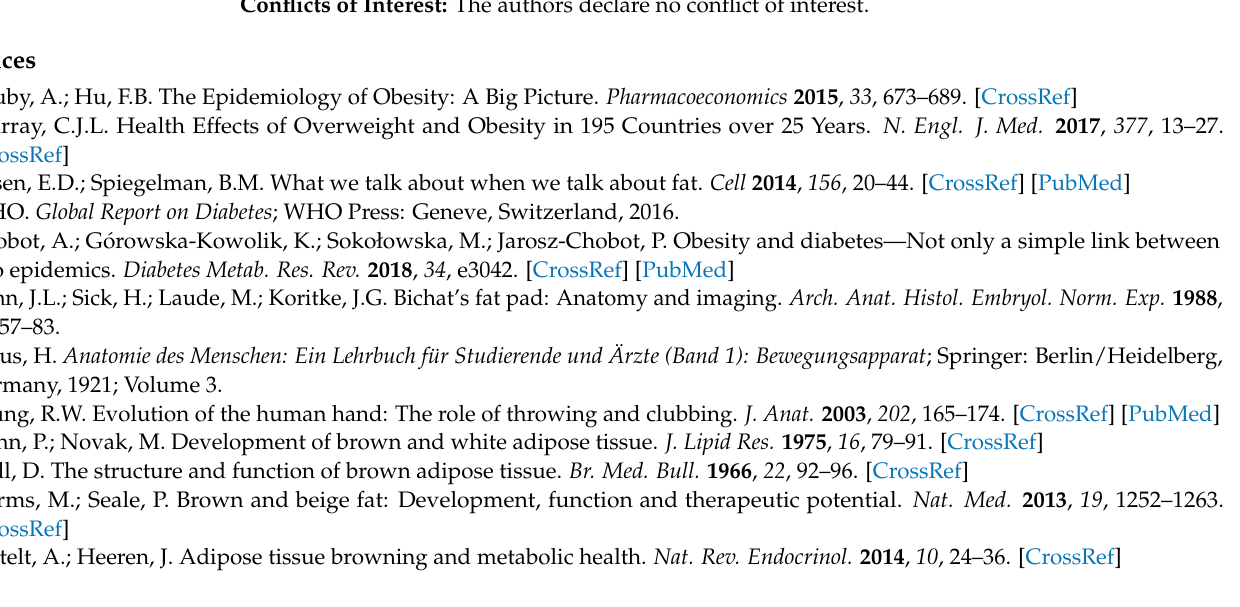
network, Table S6: Krt71 network, Table S7: Fabp3 network, Table S8: Glycam1